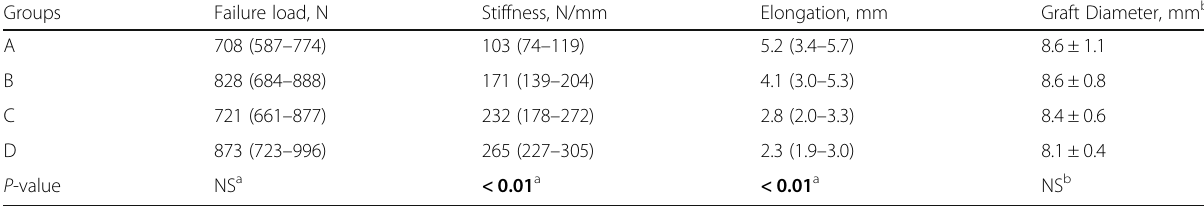
Table 1 Maximum Failure load, Stiffness, Elongation and Graft Diameter